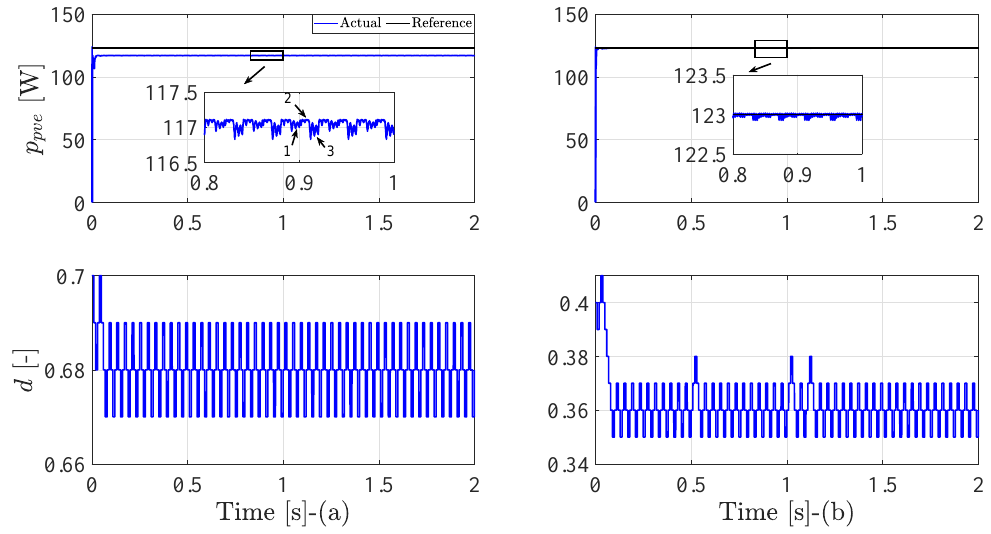
Figure 17. The performance of the P&O method under complex partial shading condition (peak at the middle): ( a ) Failure to extract the global peak ( b ) Success to obtain the global